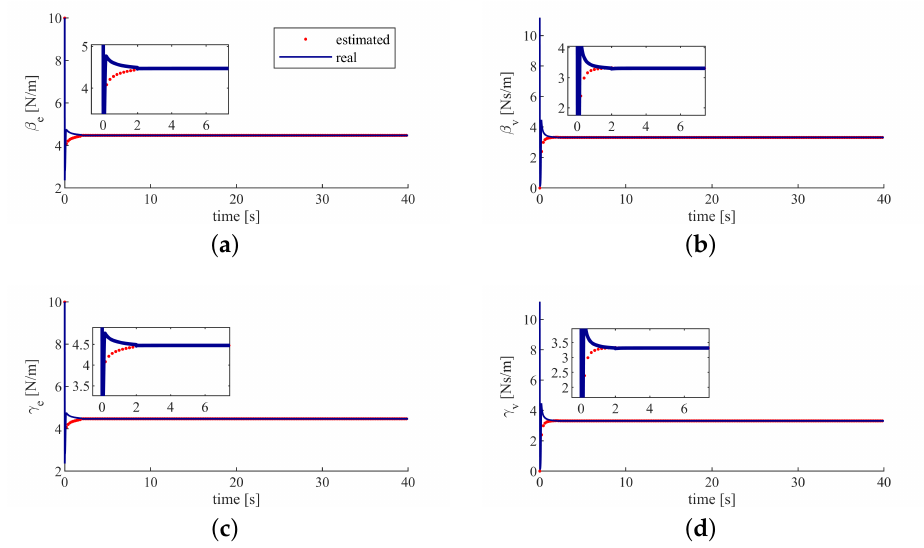
Figure 5. Control gains of humans. ( a ) the position error feedback gain of the human 1. ( b ) the velocity feedback gain of the human 1. ( c ) the position error feedback gain of the human 2. ( d ) the velocity feedback gain of the human